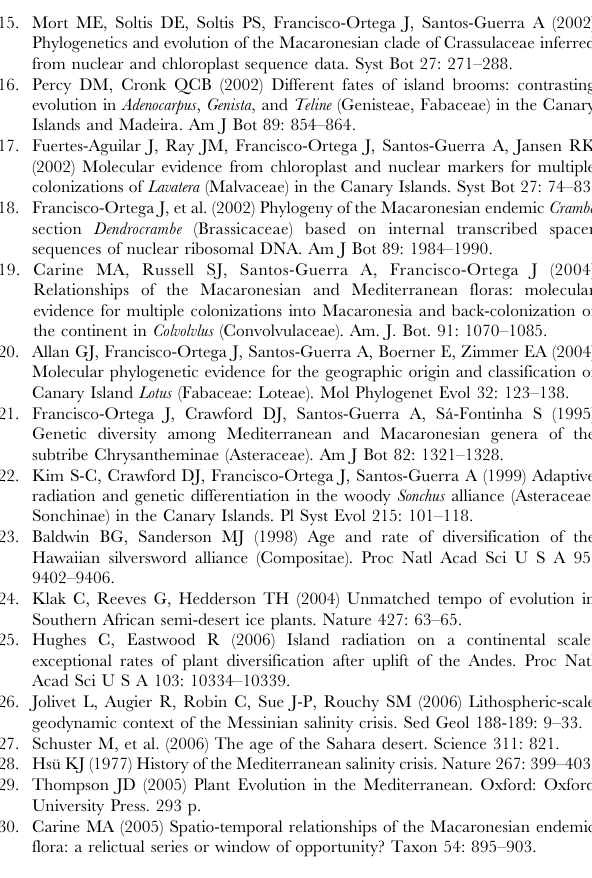
Gray circle represent calibration point. (1 =dispersal to the Canary Islands, 2= dispersal to Medeira). Figure S5 Maximum likelihood phylogram (model: K80 + G, -ln = 1176.8682) of Crambe section Dendrocrambe (Brassicaceae) based on ITS sequence. Gray circle represents calibration point. (1= dispersal to the Canary Islands, 2 =dispersal to Madeira). Found at: doi:10.1371/journal.pone.0002139.s005 (0.83 MB TIF) Figure S6 Maximum likelihood phylogram (model: TIM + I + G, -ln = 12034.2559) of the Aeonium alliance (Crassulaceae) based on ITS and cpDNA sequences. Gray circle represents calibration point. (1= Canary Islands, 2 and 2 9 = dispersal to Madeira, 3 and 3 9 = dispersal to continent, 4= dispersal to Cape Verde). Found at: doi:10.1371/journal.pone.0002139.s006 (0.93 MB